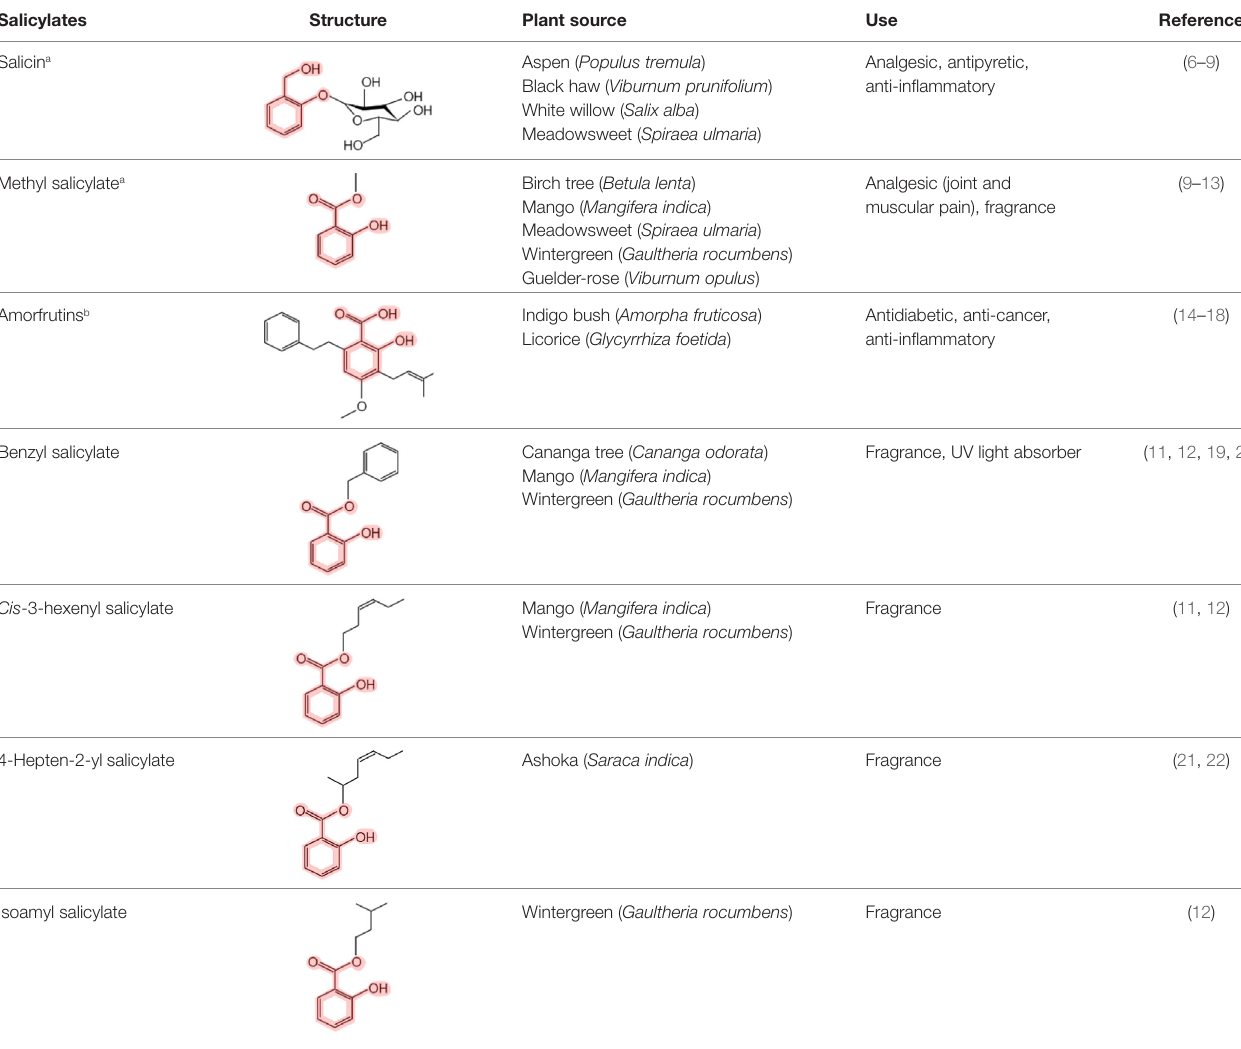
TABLe 1 | List of useful salicylates present in various